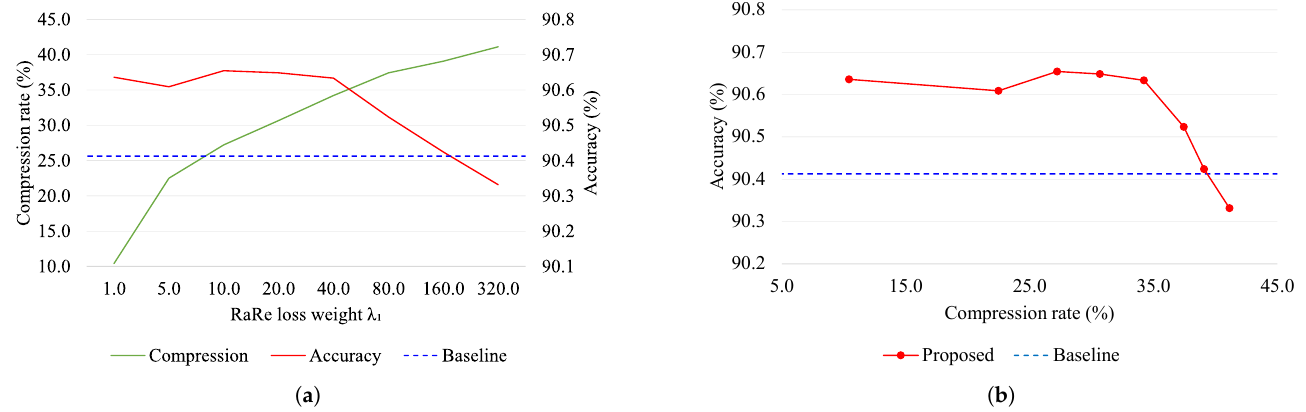
Figure 3. ( a ) The change in compression rate and accuracy with varying values of λ 1 . ( b ) Test set accuracy plotted as a function of compression rate. The compression rate of the baseline model is 0% and its accuracy is plotted in black dashed line for reference.